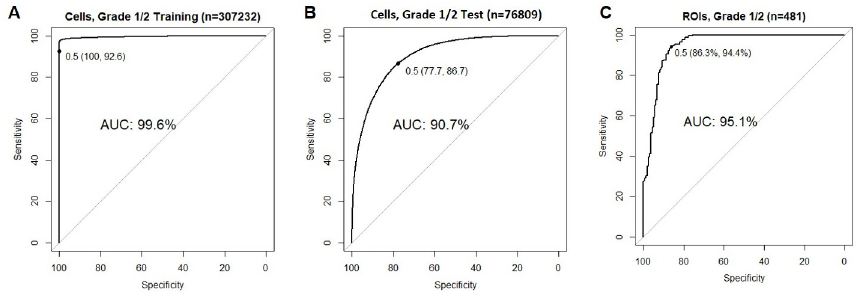
Fig 2. Random forest based modeled score for nodal disease. The ROC of RF-based nodal-risk score, NRS, models for training set cells (A), test set cells (B), and Grade 1 and Grade 2 ROIs (C) with the 0.5 (solid black dot) indicated as the best cutoff with the highest performance (specificity and sensitivity). The area under the curve, sensitivity, and specificity are shown in percentages. Abbreviations: NRS, nodal risk score; ROC, receiver operating characteristic curve; AUC, area under the curve; Grade 1, well differentiated tumors; G2, moderately differentiated tumors; ROIs, regions of interest; LN0, lymph node negative; LN+, lymph node positive.